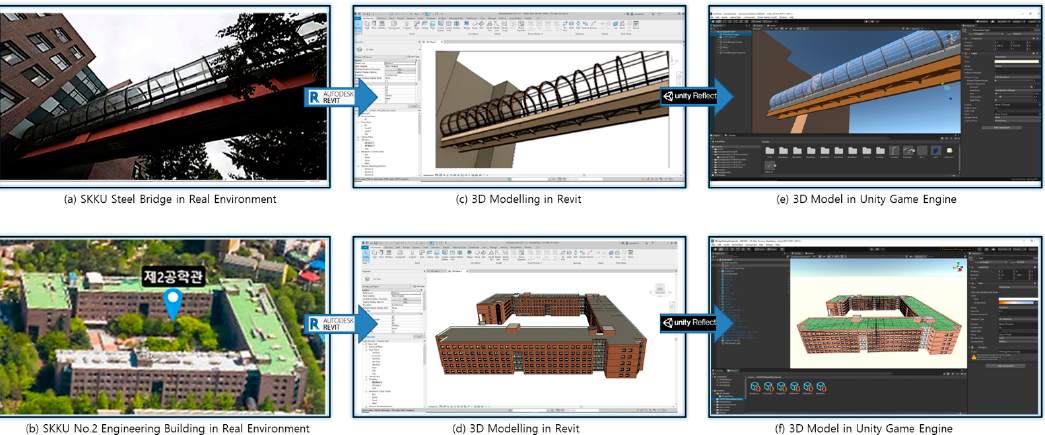
Figure 6. Three-dimensional modeling process for SKKU steel bridge and No. 2 engineering building. Real environment: ( a ) bridge, and ( b ) building. Model in Revit: ( c ) bridge, and ( d ) building. Model in Unity: ( e ) bridge, and ( f ) building.